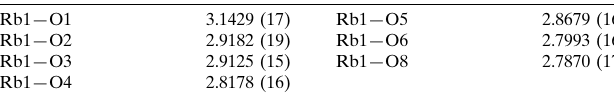
Selected bond lengths (A˚ ).